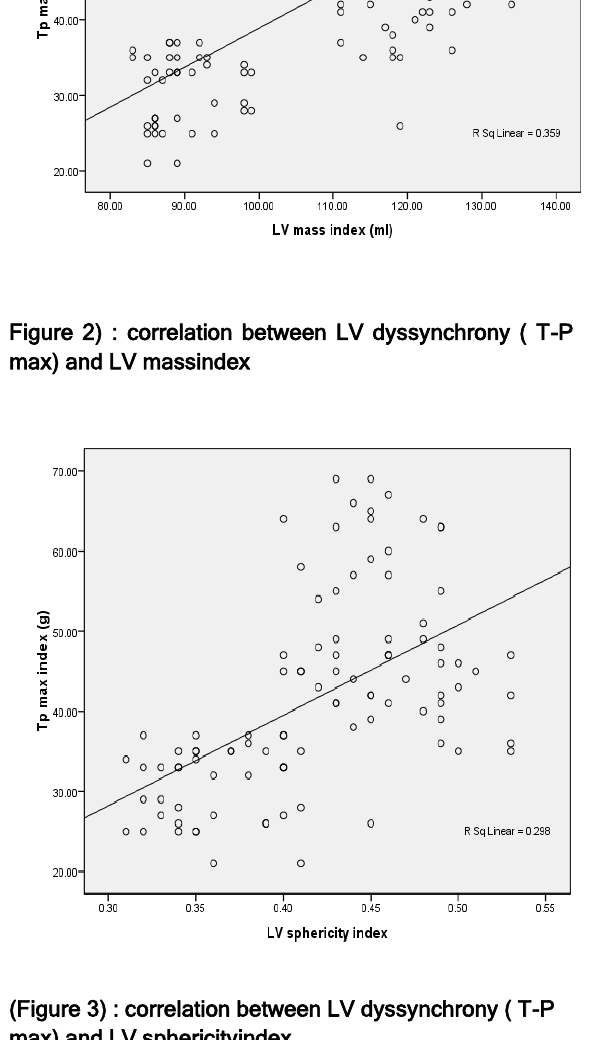
(Figure 3) : correlation between LV dyssynchrony ( T-P max) and LV sphericityindex Discussion: Age of the patients was ranging from (48.5- 66.5y) that show no relationwith LV systolic dyssynchrony (p-value =0.2) which is similar to that foundby Benjamin Yang et al (11) . Left ventricular systolic dyssynchrony ( T-Pmax>50 msec) was identified in20 patients (33.3%) in the hypertensive group which is similar to that